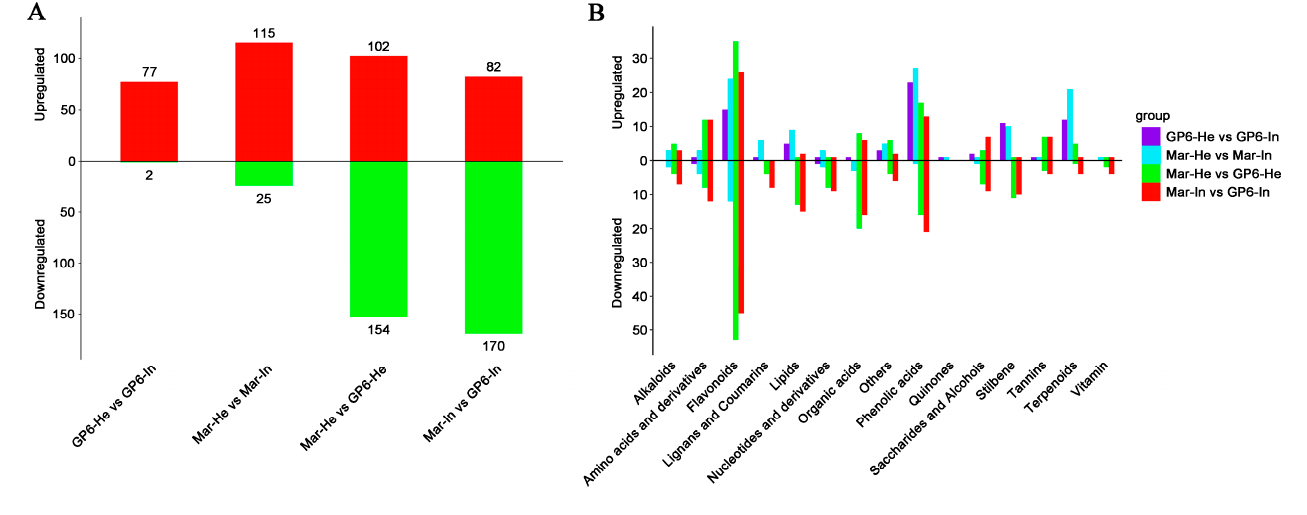
Figure 3. ( A ) The number of differentially expressed metabolites of each pairwise comparison of grapes; ( B ) Classification of differentially expressed metabolites of four pairwise comparisons.